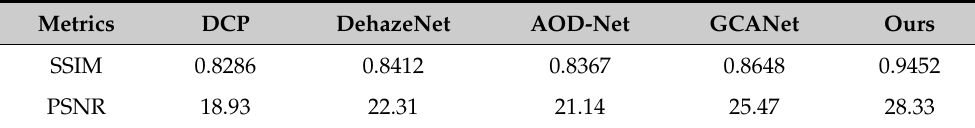
Table 3. Quantitative comparison of image dehazing from synthetic datasets. Metrics DCP DehazeNet AOD-Net GCANet